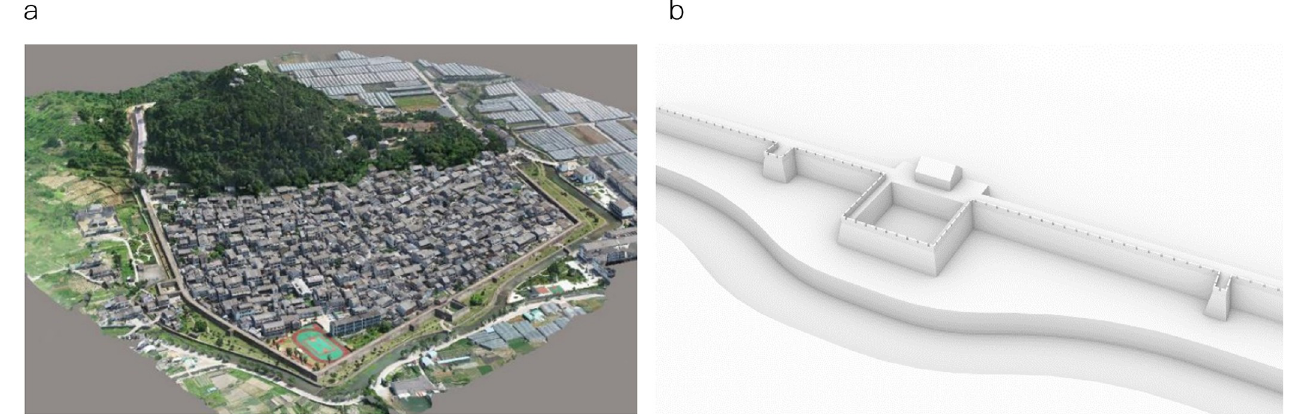
Fig 4. The 3D point cloud model of Puzhuang Suo-Fort (a) and the model of the south wall of Puzhuang Suo-Fort (b).